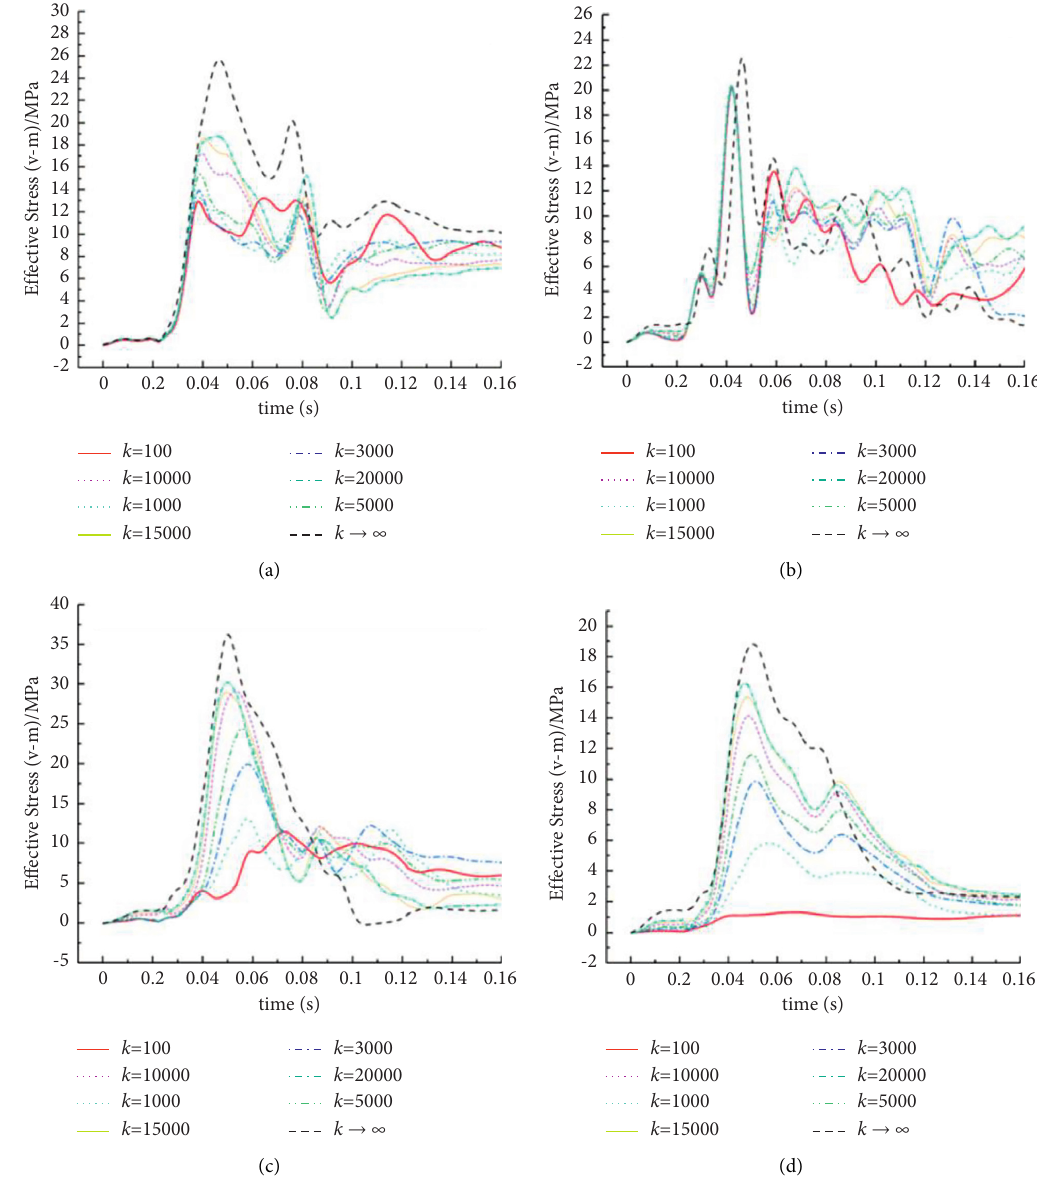
Figure 10: von Mises equivalent stress time history curves at study points. (a) Vault. (b) Spandrel. (c) Arch foot. (d) Wall Similar to the pressure time history curve, the von Mises equivalent stress time history curve showed an oscillatory attenuation after reaching the peak value. The curves of arch foot and wall foot gradually reached a plateau over time. The time for study points to reach von Mises equivalent stress peak values was different. The vault peaked first, while the wall foot was the last to peak. The times from the top to the bottom of the structure were prolonged successively. The von Mises equivalent stress at the explosion stage ( t � 0.022 ∼ 0.16 s) was much higher than that at the pene- tration stage ( t � 0 ∼ 0.022 s), and the effect of explosive after explosion on the dynamic response of the structure was even greater.